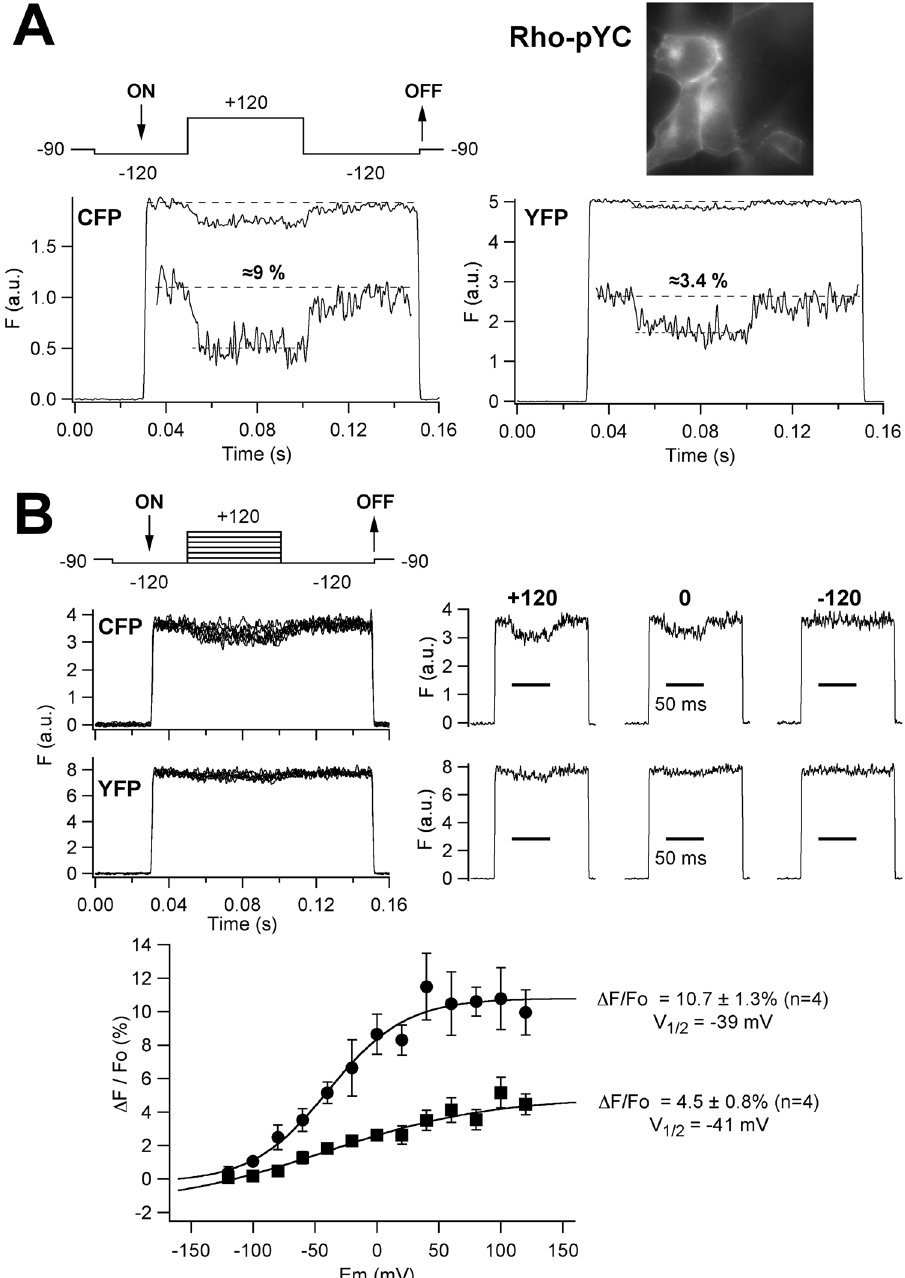
Figure 3. Voltage-dependent DPA-induced effects on patch-clamped HEK293 cells expressing the plasma membrane-targeted CFP-YFP Rho-pYC tandem. ( A ) Time course of the fluorescent response on voltage pulses from − 120 to + 120 mV (upper left panel) in the presence of 10 μ M DPA. A fluorescence image of the cells (100x oil-immersion objective) demonstrating the marked plasma membrane distribution of the Rho-pYC signal is shown on the right. Representative fluorescence traces at excitation wavelengths of 440 (CFP) and 510 nm (YFP) are shown. Averaged responses from 50 trials delivered at 1 s intervals are illustrated on the graphs. Expanded sections of the fluorescence traces are shown in the insets. The estimated Δ F/Fo values expressed as % are also indicated. ( B ) Voltage dependence of the DPA-induced effects. Families of superimposed fluorescence traces in response to voltage steps as illustrated at the top are shown on the upper left panel. Separate traces obtained at + 120, 0 and − 120 mV are shown on the right. Plots of Δ F/Fo versus voltage with a Boltzmann curve fitted to the data, corresponding to the CFP (circles) and YFP (squares) signals, are shown at the bottom. V 1/2 and maximal Δ F/Fo values obtained from the curves are